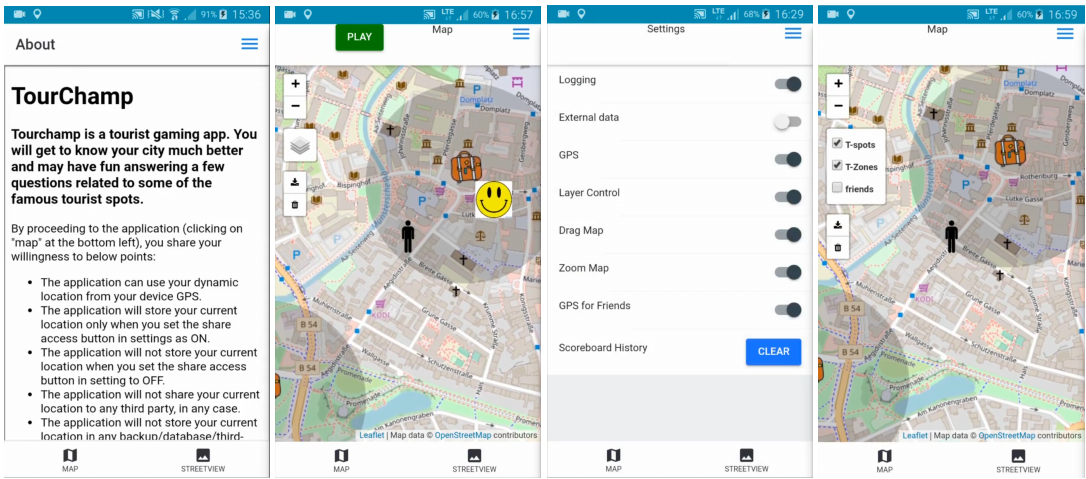
Figure 4. TourChamp (left to right): ( a ) notice; ( b ) visual indications of friends’ presence when location sharing is enabled; ( c ) setting options to adjust location sharing (GPS) for public or only friends; ( d ) layered setting adjustment to enable/disable location